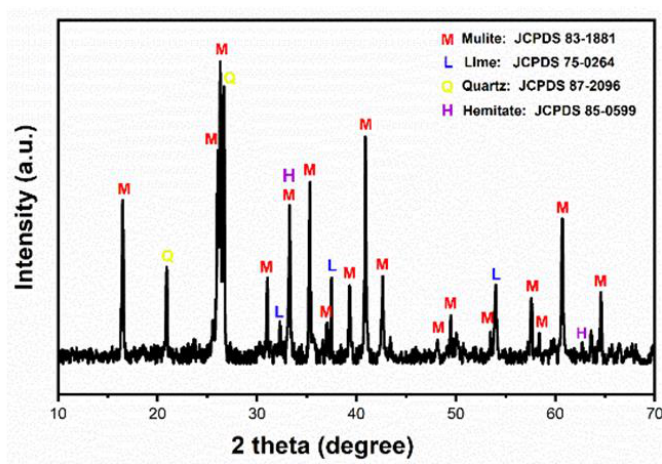
Figure 1. Analysis of different mineral phase composition of original fly ash.